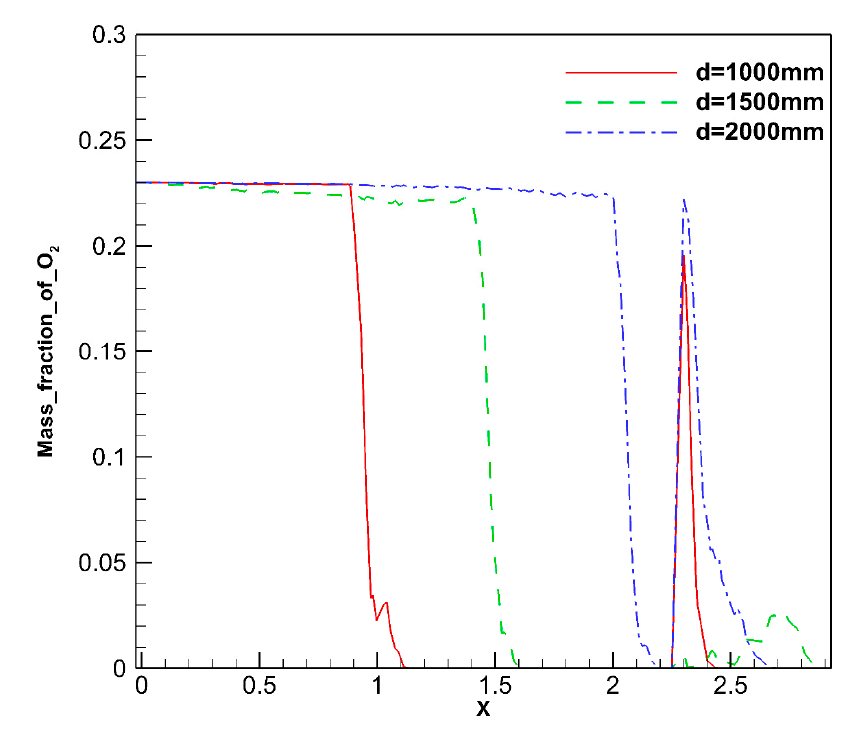
Figure 20. Mass fraction of oxygen on the line at Y = 1.09 m with the rubbish height = 700 mm and the cooling air with the mass flow rate = 0.07 kg/s.